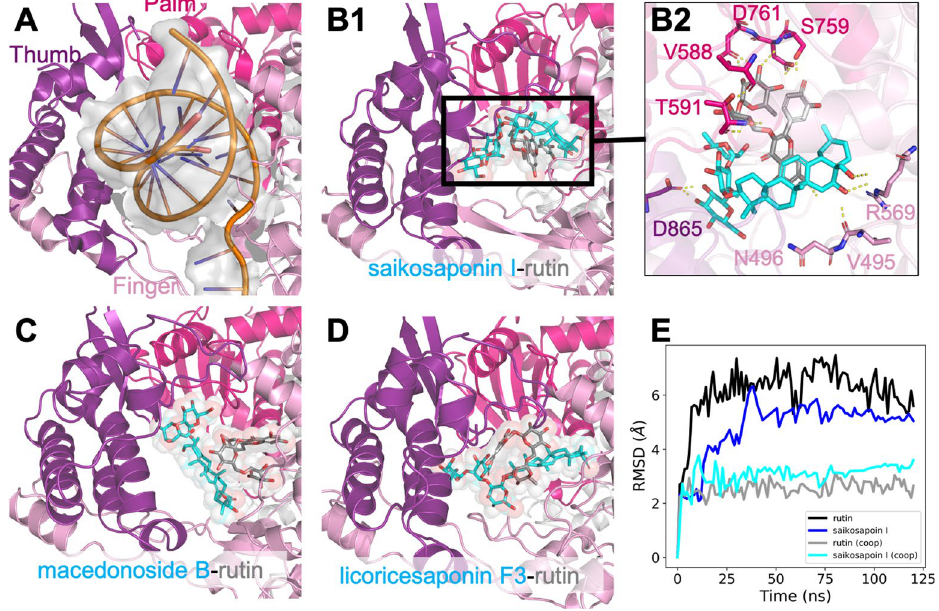
Figure 4. Cooperative binding of rutin and triterpenes at the RNA-binding site of RdRp. ( A ) Cartoon illustration of the RNA-binding site surrounded by the so-called Thumb, Palm, and Finger regions (PDBID: 7BV2). ( B – D ) Final snapshots of MD simulations of rutin and a triterpene compound binding to RdRp. ( E ) Time evolution of ligand RMSD of rutin or saikosaponin I-bound simulations as well as the saikosaponin I-rutin RdRp complex simulations. It is shown that the cooperative binding reduces the ligand flexibility at the wide RNA-binding site of RdRp. The cartoon illustration was prepared in Pymol (version 2.3.4)